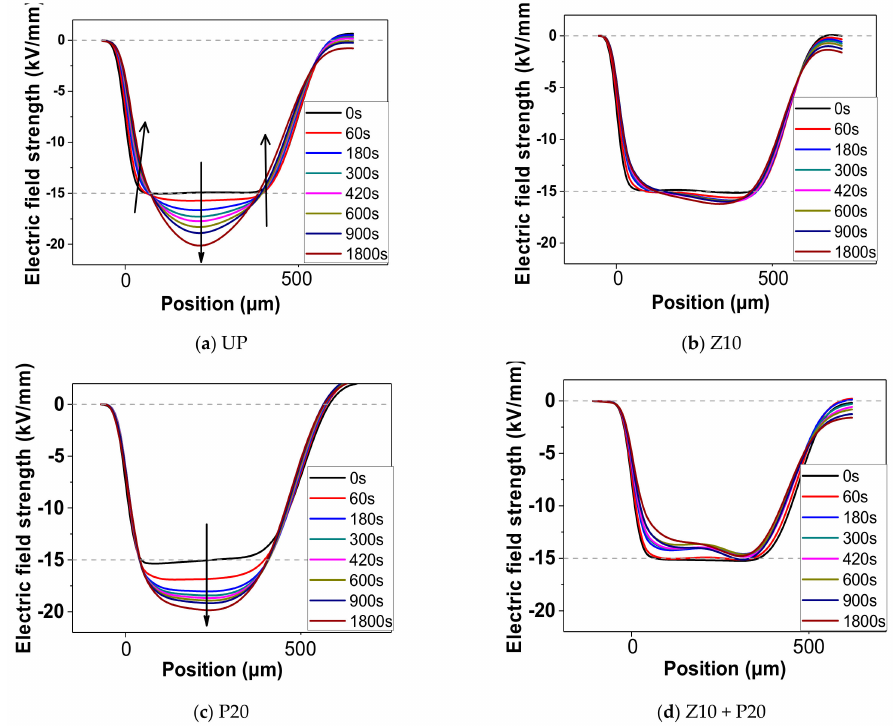
Figure 12. Electric field distribution for di ff erent samples: ( a ) UP, ( b ) Z10, ( c ) P20, and ( d ) Z10 + P20.